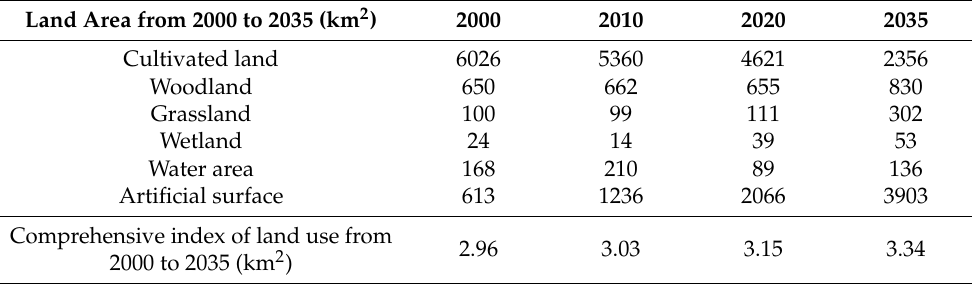
Table 6. Land use transfer matrix from 2000 to 2035.